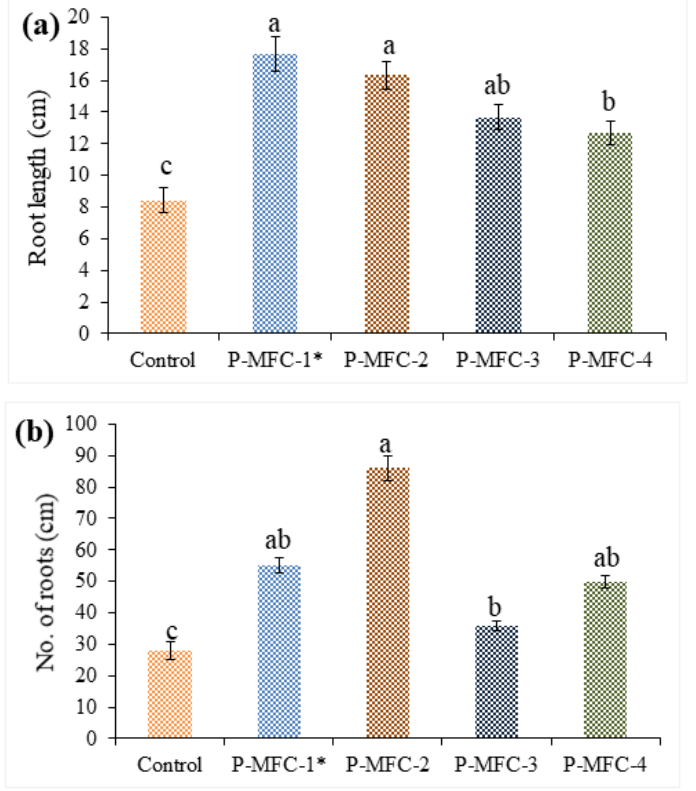
Figure 2. Impact of the P-MFC on the Stevia rebaudiana rhizosphere: ( a ) root length (cm), and ( b ) number of roots during the study. Means with the same letter for each figure are statistically equal (Tukey, p < 0.05).